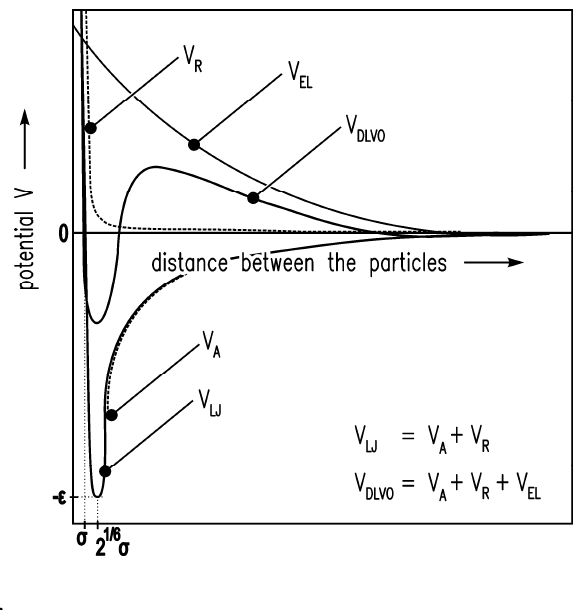
Figure 4. Lennard-Jones (12-6) and DLVO potential.